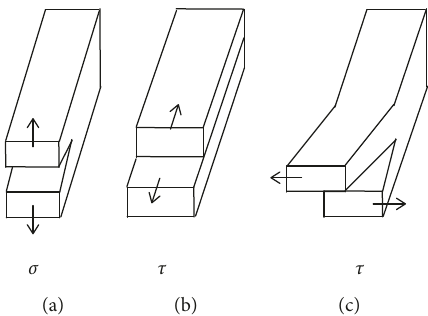
Figure 2: Crack type. (a) I mode crack. (b) II mode crack. (c) III mode crack.